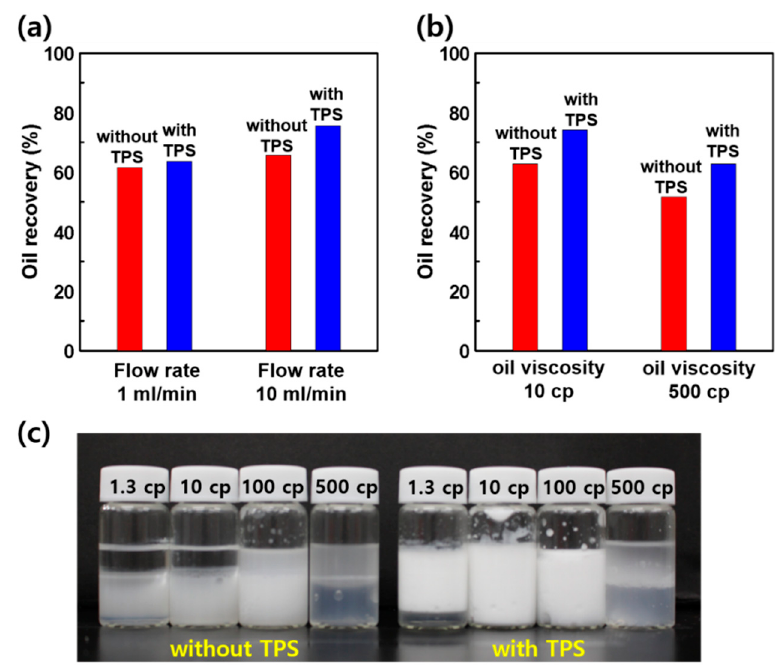
Figure 9. Oil recovery as a function of ( a ) flow rate and ( b ) oil viscosity in the presence or absence of a zwitterionic surfactant. ( c ) Emulsion stability as a function of oil viscosity in the presence or absence of a zwitterionic surfactant.